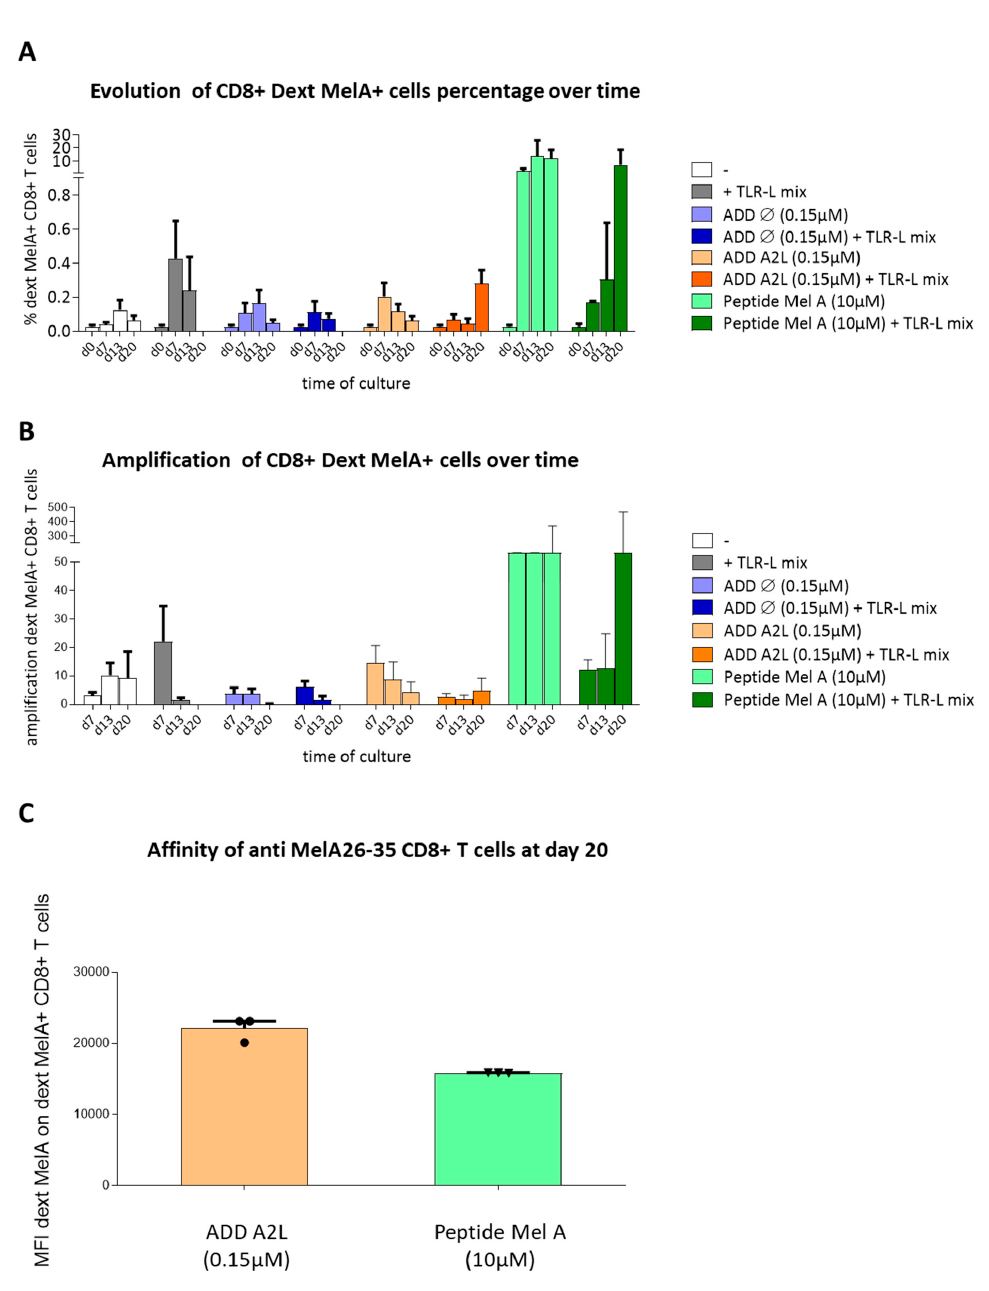
Figure 5. ADDomer displaying A2L epitope efficiently cross-prime peptide-specific CD8+ T cells dotted with a high affinity. PBMC were cultured in control conditions or with empty ADDomer (ADD Ø) or ADD A2L in the presence or not of a mixture of TLR-L. Cultures were restimulated